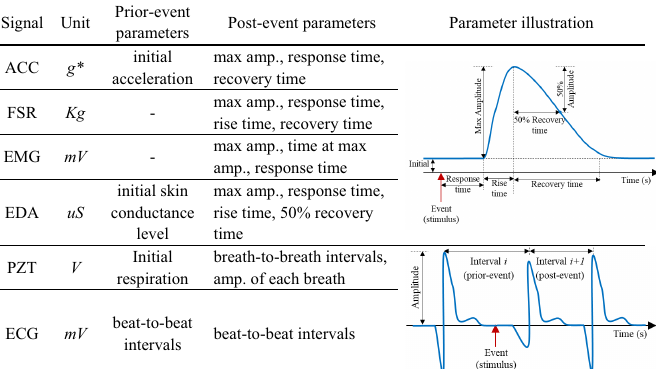
Prior-event Signal Unit Post-event parameters Parameter illustration parameters